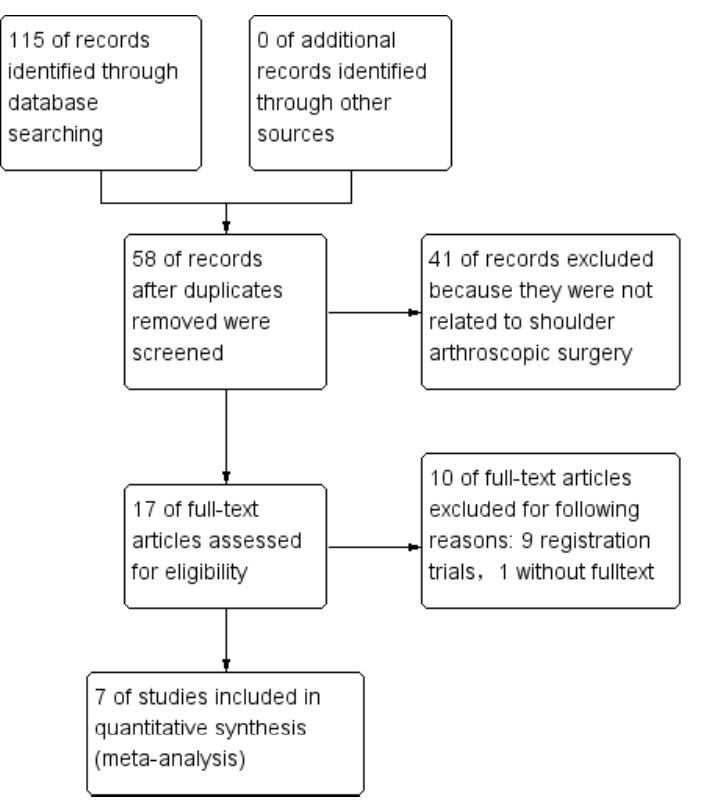
Figure 1. Study flow diagram.